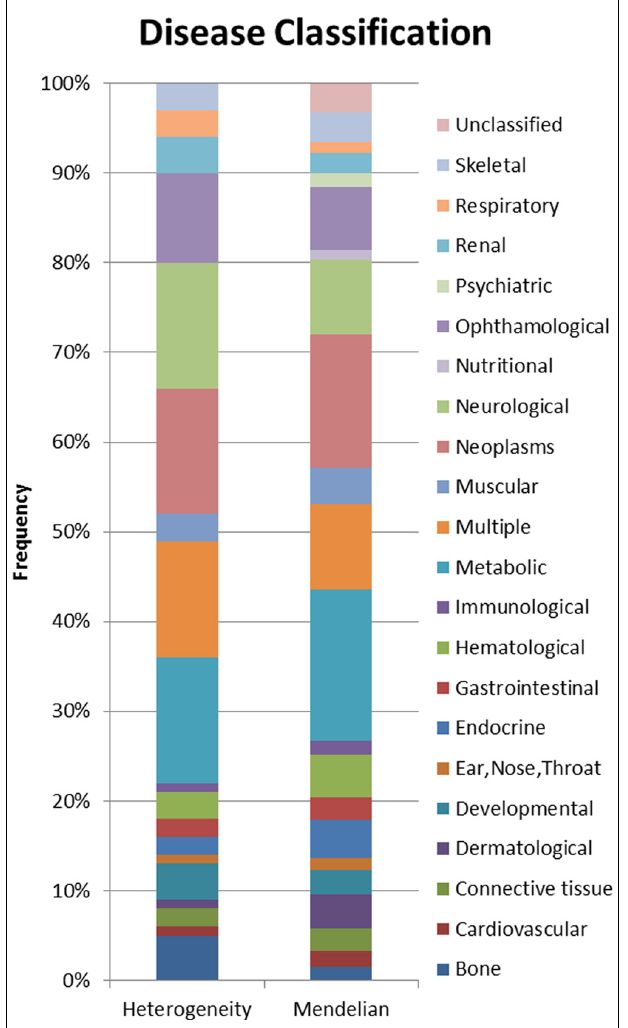
FIGURE 2 | Proportional display of diseases by MESH classification. The proportion of locus heterogeneity (left) and Mendelian (right) disease genes characterized in our study that affect different physiological systems. Colors correspond to specific physiological systems affected by these disease genes (key at far right).